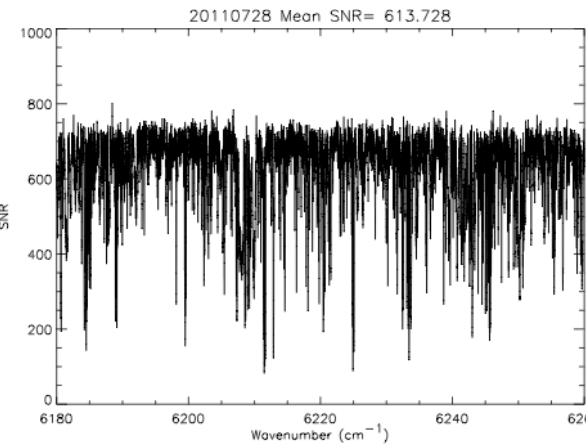
Figure 10. Signal-to-noise ratio (SNR) derived for 28 July 2011 from the variable-SNR technique (see